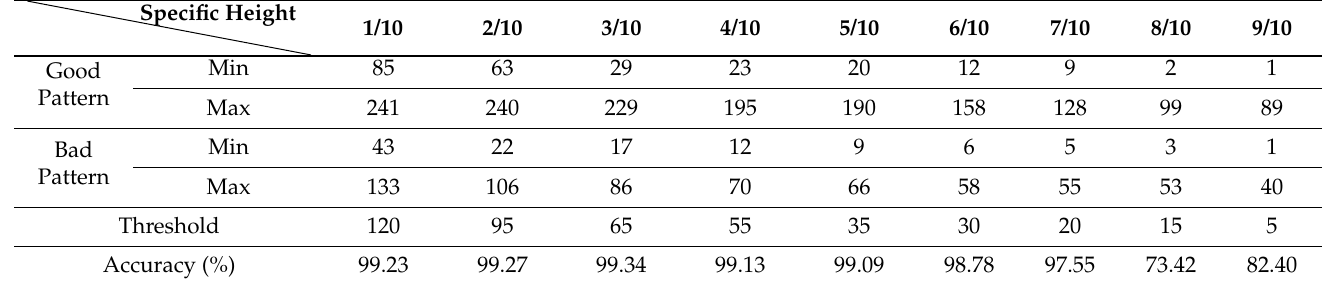
Table 1. Classification accuracy according to the height of the image